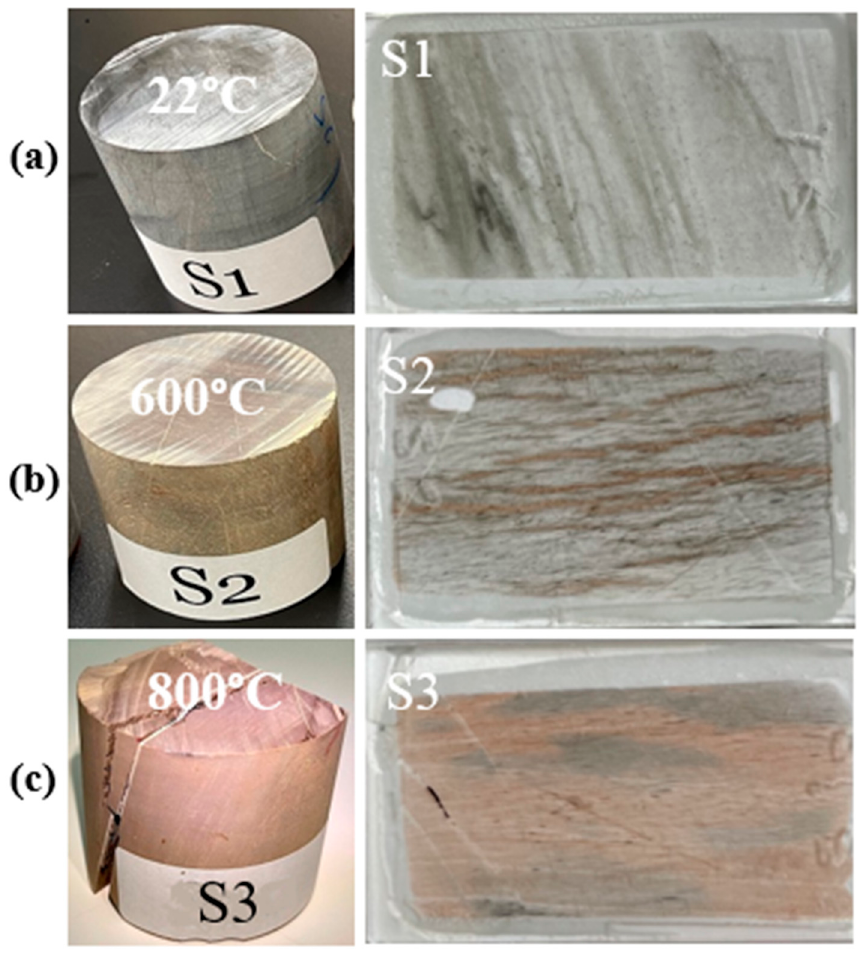
Figure 3. To the left; hand-held specimens, to the right; thin sections from the representative area of hand-held specimens ( a ) S1 (22 °C), ( b ) S2 (600 °C), ( c ) S3 (800 °C).